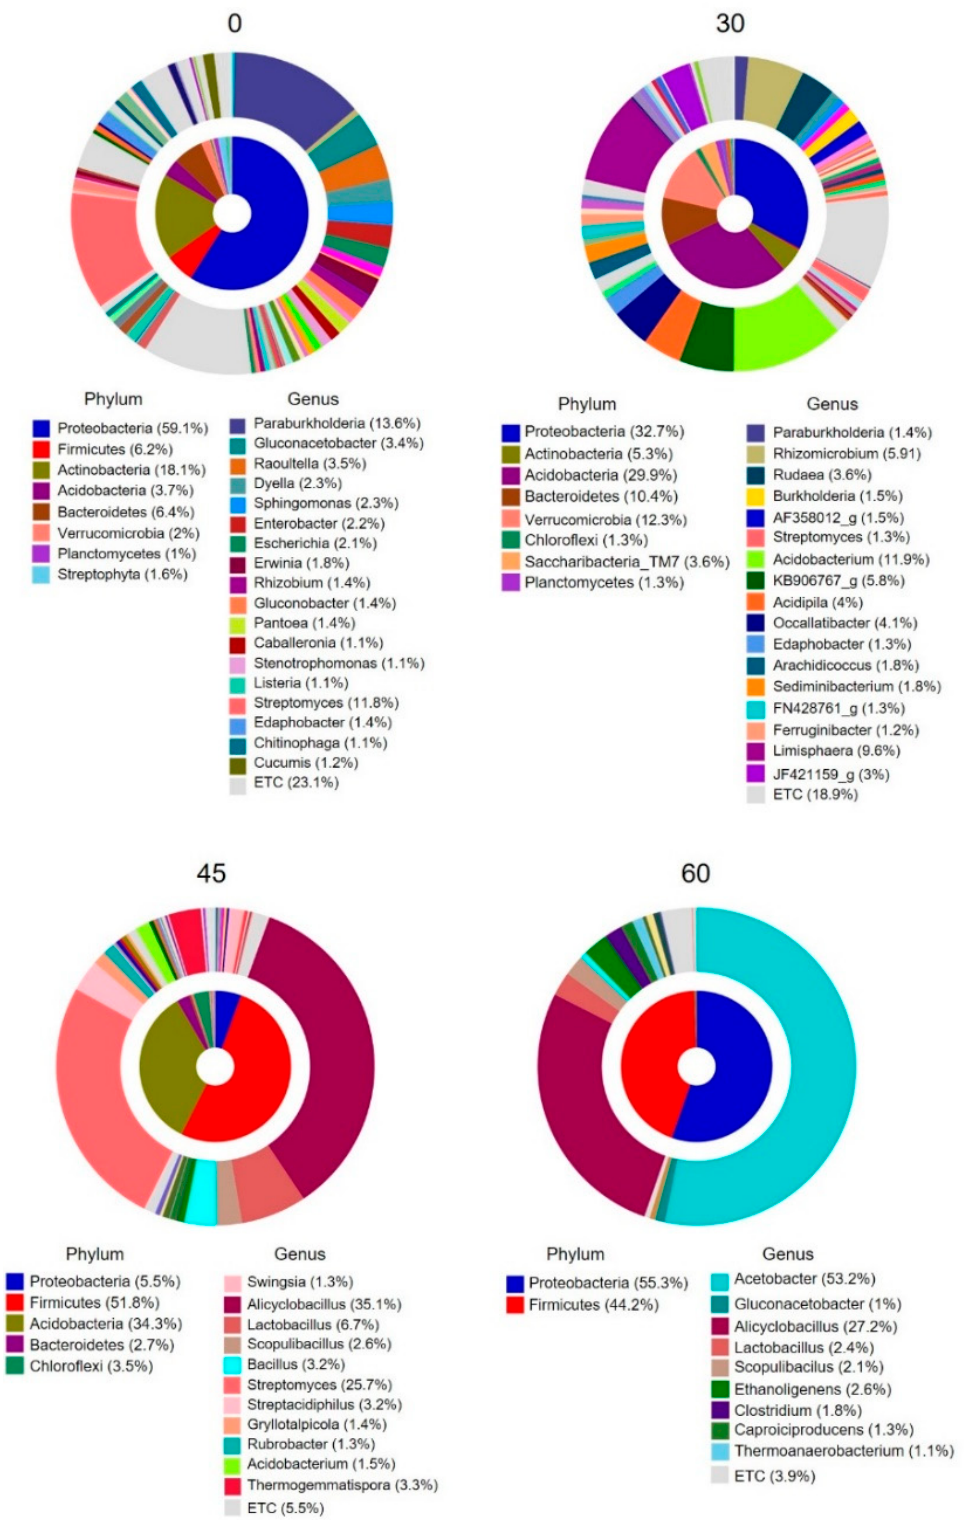
Figure 7. Bacterial composition profiles in 0, 30, 45, 60-day fermented oak tree sawdust group. Microbial analysis of the 0, 30, 45, and 60-day fermented oak tree sawdust conducted using a 454 GS FLX titanium next-generation sequencing (NGS) system (Roche, Branford, CT) according to the manufacturer’s instructions (Lee and Eom, 2016). Levels of phyla and genera of each bacteria with more than 1% of their proportion in 0, 30, 45, 60-day fermented oak tree sawdust was displayed (inner area: Phylum, outer area: